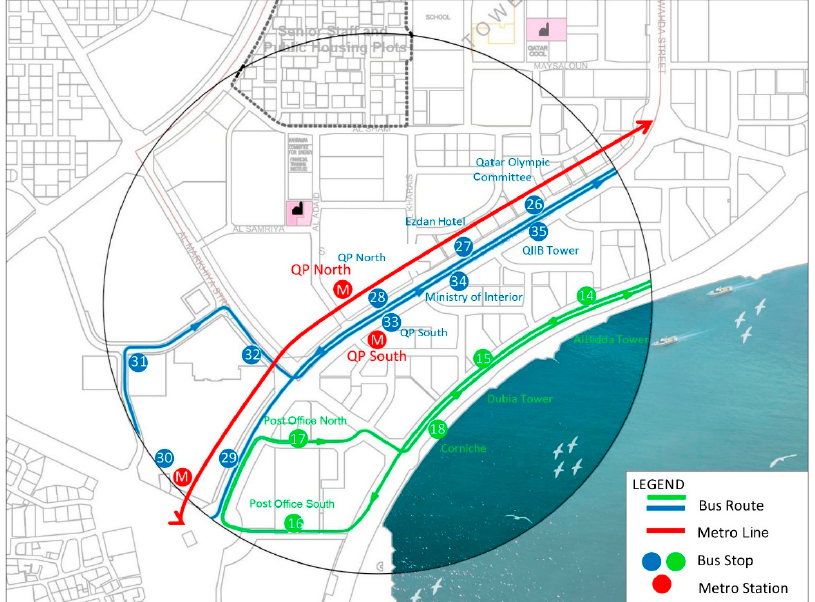
16 of 27 Figure 19. ( left ) map showing building density; ( right ) condition of buildings in the study area (Source: the Authors). 6. Connectivity Intramodality and Transport Hubs QNV 2030 foresees the development of a sustainable transportation system, includ- ing the metro project and the massive development of the bus system. This should de- crease residents’ reliance on automobile use, which is still the dominant transport mode in the country. There are three road types in the studied area, which vary from arterial roads with three lanes in each direction, to collector roads with two lanes in each direction,